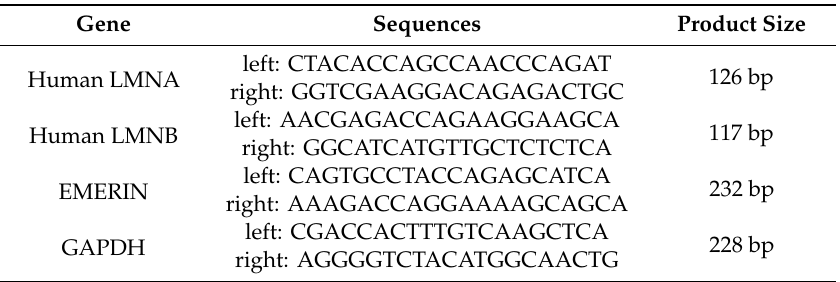
Table 2. Primer pairs used for RT-PCR.